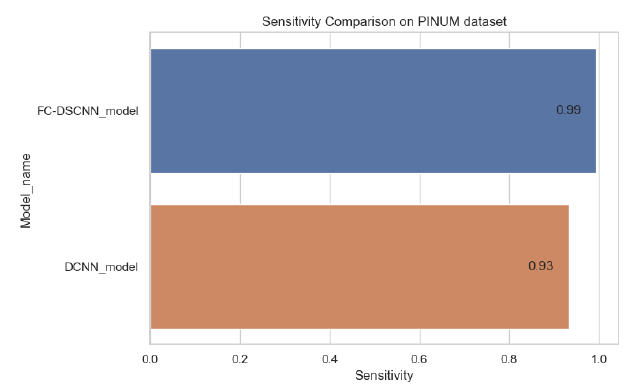
Figure 11. DCNN training loss and accuracy on the DDSM dataset.